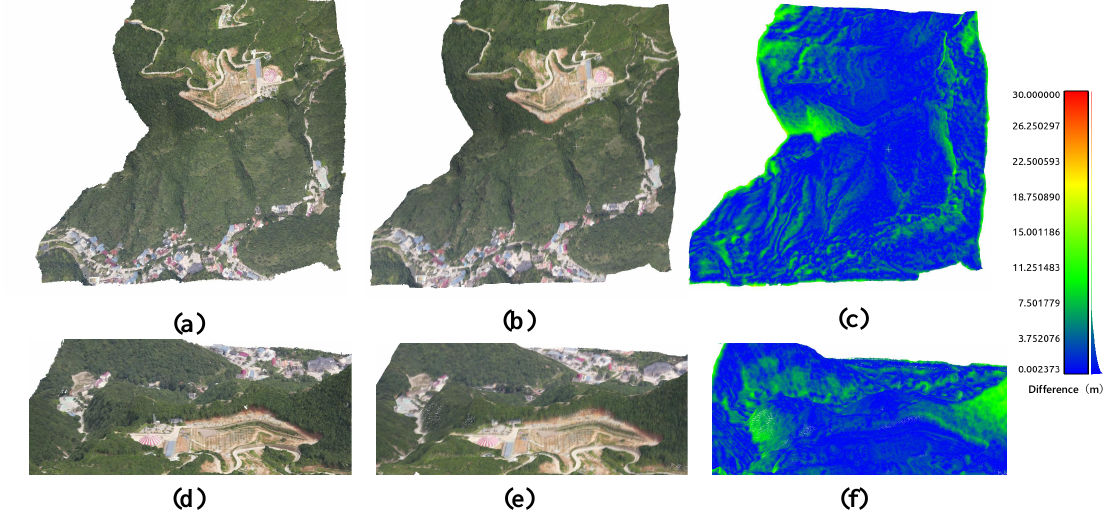
Figure 17. The image sequence data is Mixed Zone-2 in Table 3. Reconstruction results compared with Photoscan. ( a , d ) are the top view and the front view of the model generated by Photoscan offline. ( b , e ) are the corresponding results generated by our real-time approach. ( c , f ) are the difference pseudo-color